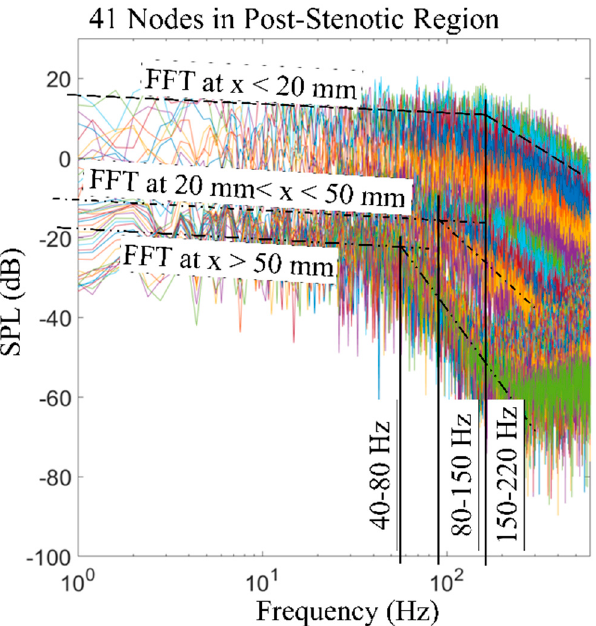
Figure 12. FFT of the wall pressure fluctuations at 41 nodes along the wall in the post-stenotic region. Break frequencies and ranges of locations are included. SPL: sound pressure level.